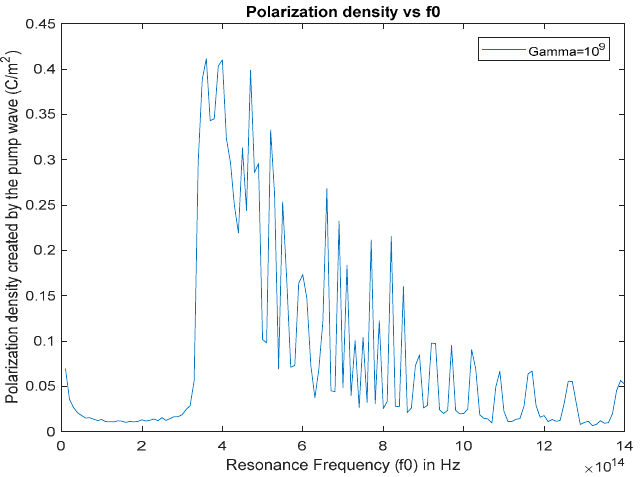
Figure 5. Maximum polarization density (created by the pump wave) inside the cavity at x = 5.73 µ m for 0 < t < 30 ps, γ = 1 × 10 9 Hz, versus f 0